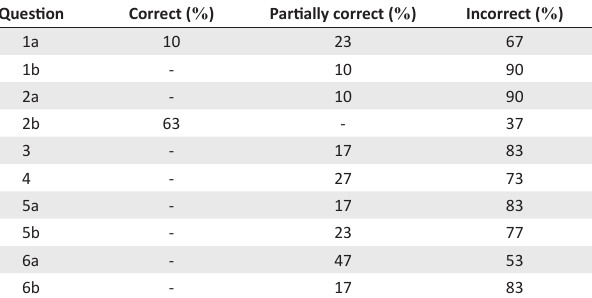
TABLE 1: Summary of findings ( N = 30). Question Correct ( % ) Partially correct ( %